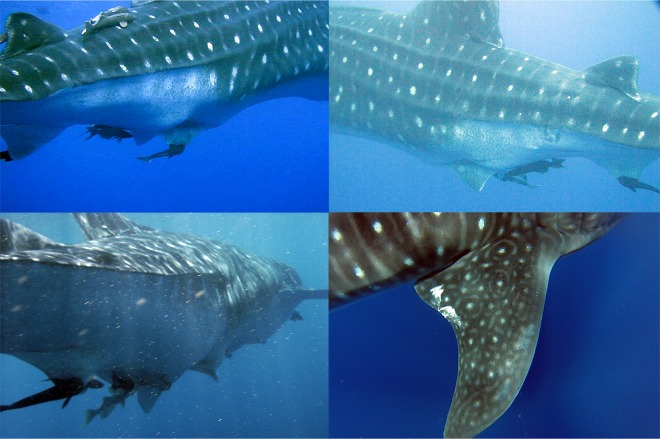
Females showing indications of reproductive activity.R. typus females showing swollen pelvic region and bite scar on the pectoral fins, suggestive of mating, recorded in the ASPSP. Credit: Bruno Macena©.